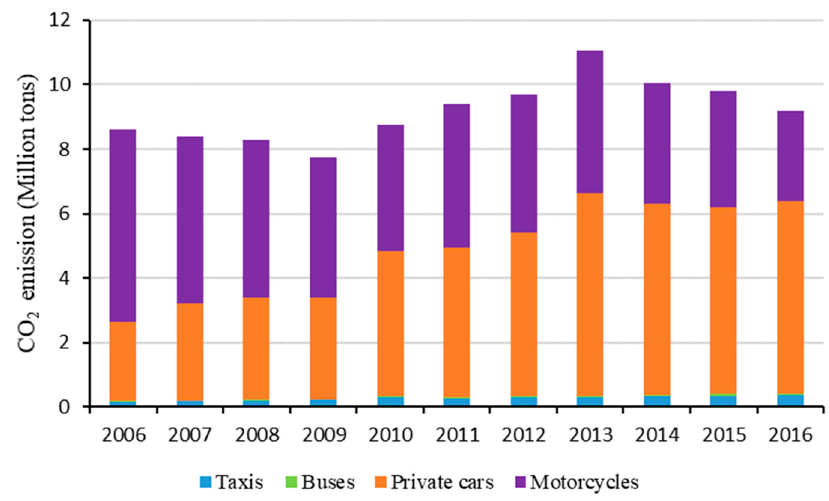
Figure 6. The modal structure of CO 2 emissions from transportation of the Pearl River Delta, 2006 – 2016.